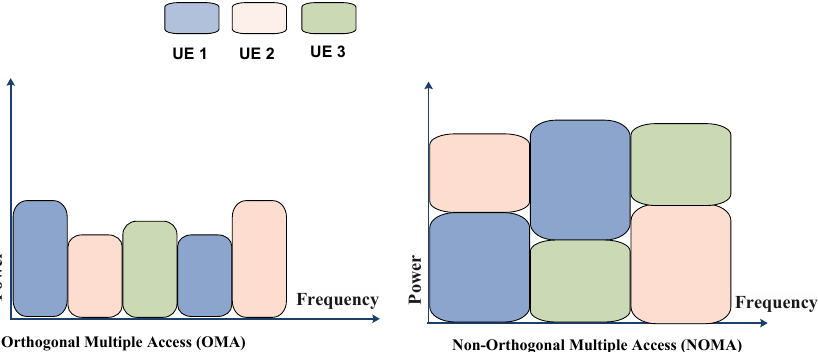
Figure 3. Pictorial representation of orthogonal and Non-Orthogonal Multiple Access